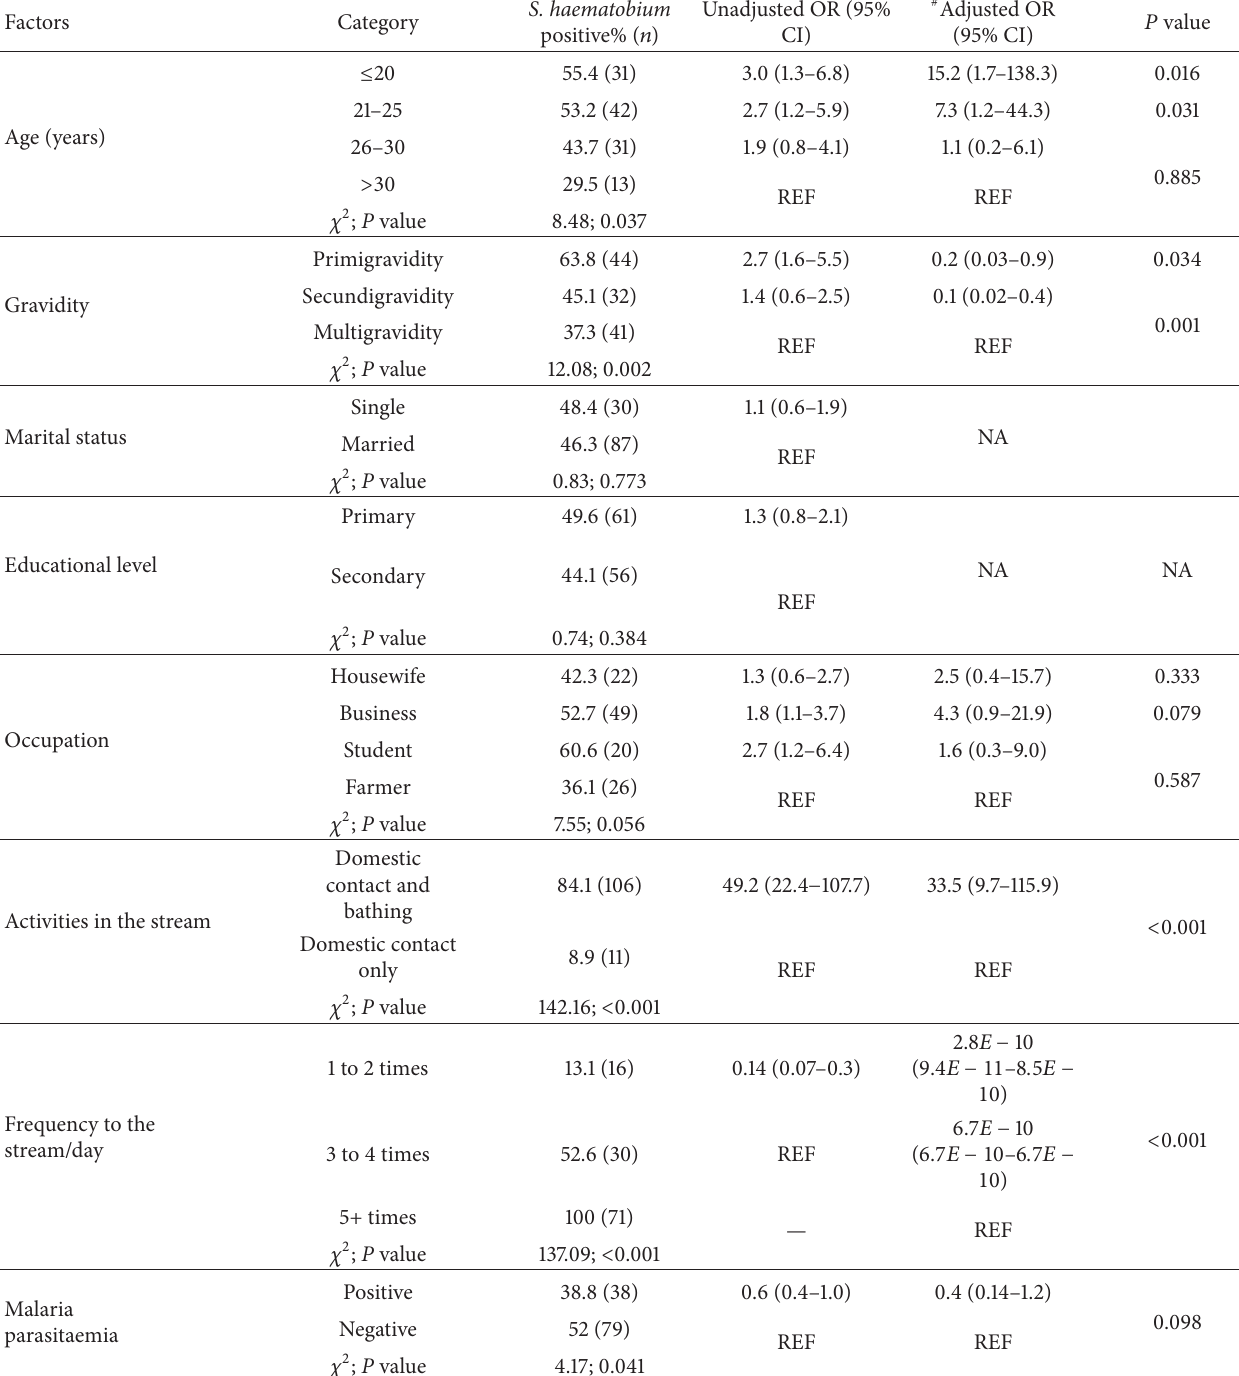
Table 2: Risk factors associated with S. haematobium infection among pregnant women in Munyenge.